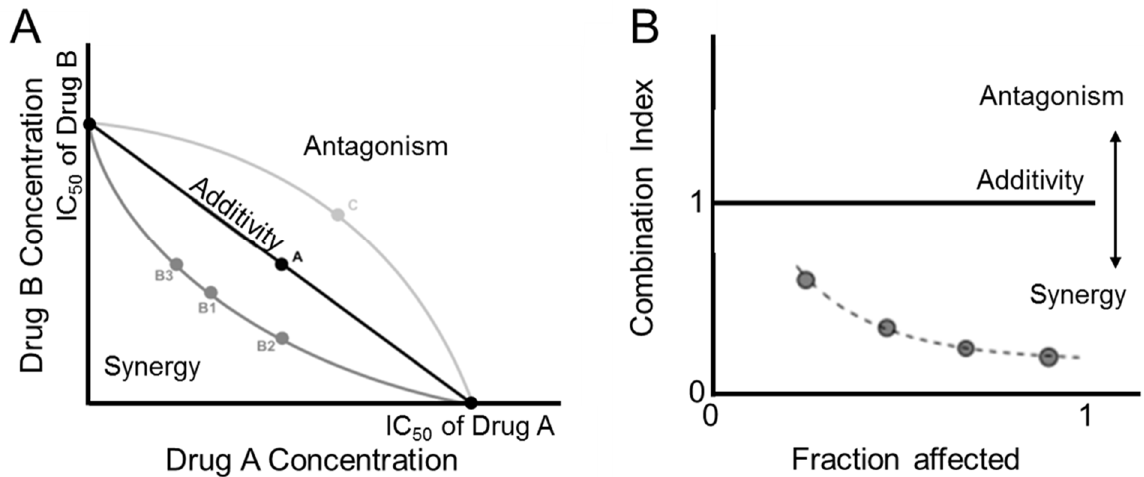
Figure 2. ( A ) Isobologram to visualize effect of combining drug A and B. The line between the IC50 of drug A and B indicates an additive effect. Below the line of additivity indicates synergistic drug interactions; above the line of additivity indicates antagonistic drug interactions. ( B ) Visual representation the combination index ( CI ) versus fraction affected (f A ) Figure adapted from [37], Copyright © 2012 Breitinger. Licensee IntechOpen.